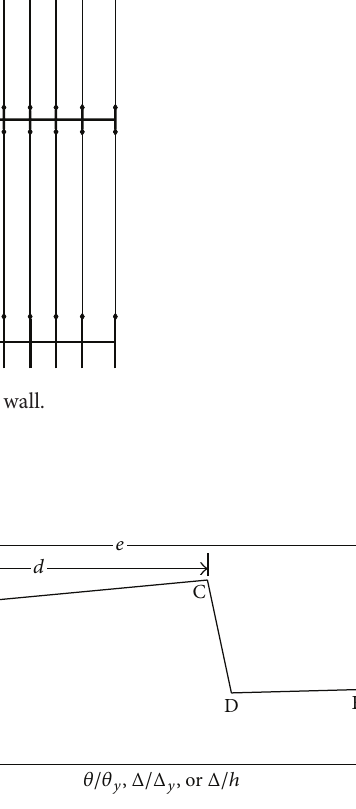
Figure 13: Generalized force-deformation relationships for compo-